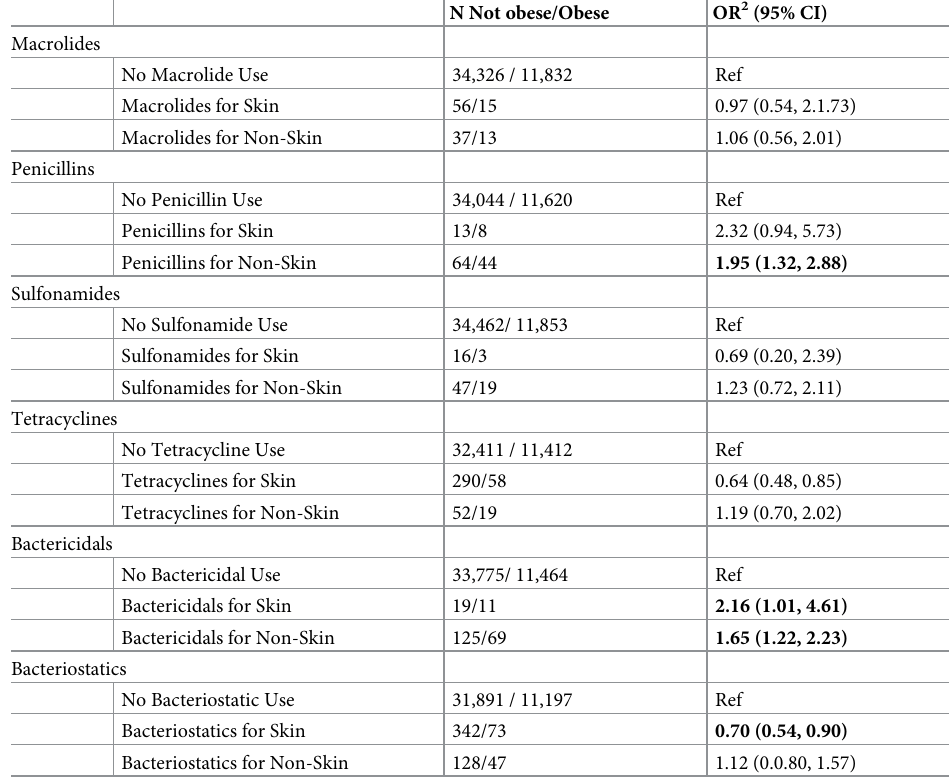
Table 4. Associations between antibiotic use 1 during the 4 th decade of life and obesity at enrollment, according to indications for use 3 .